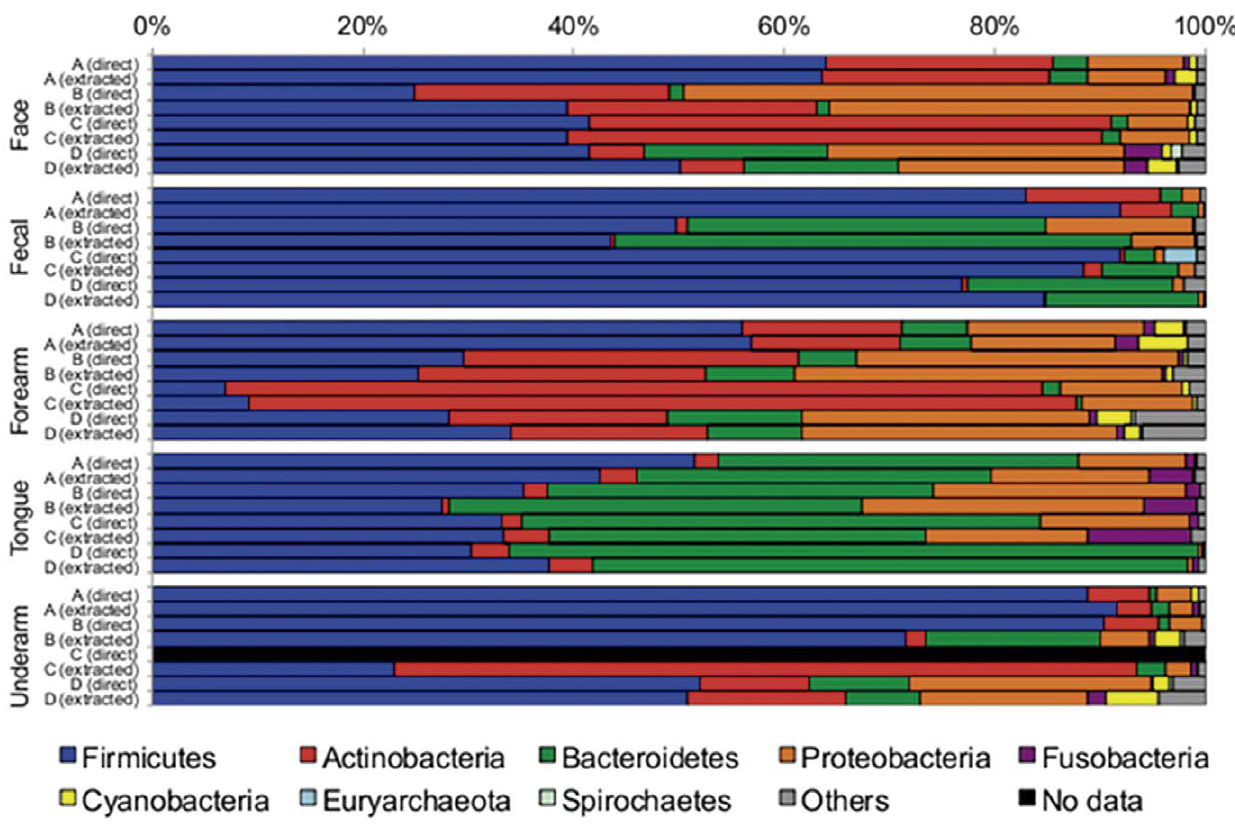
Figure 3. Average taxonomic composition of the various body habitats observed using both the direct and standard extraction/ purification protocols. Samples are grouped by body habitat and individuals.